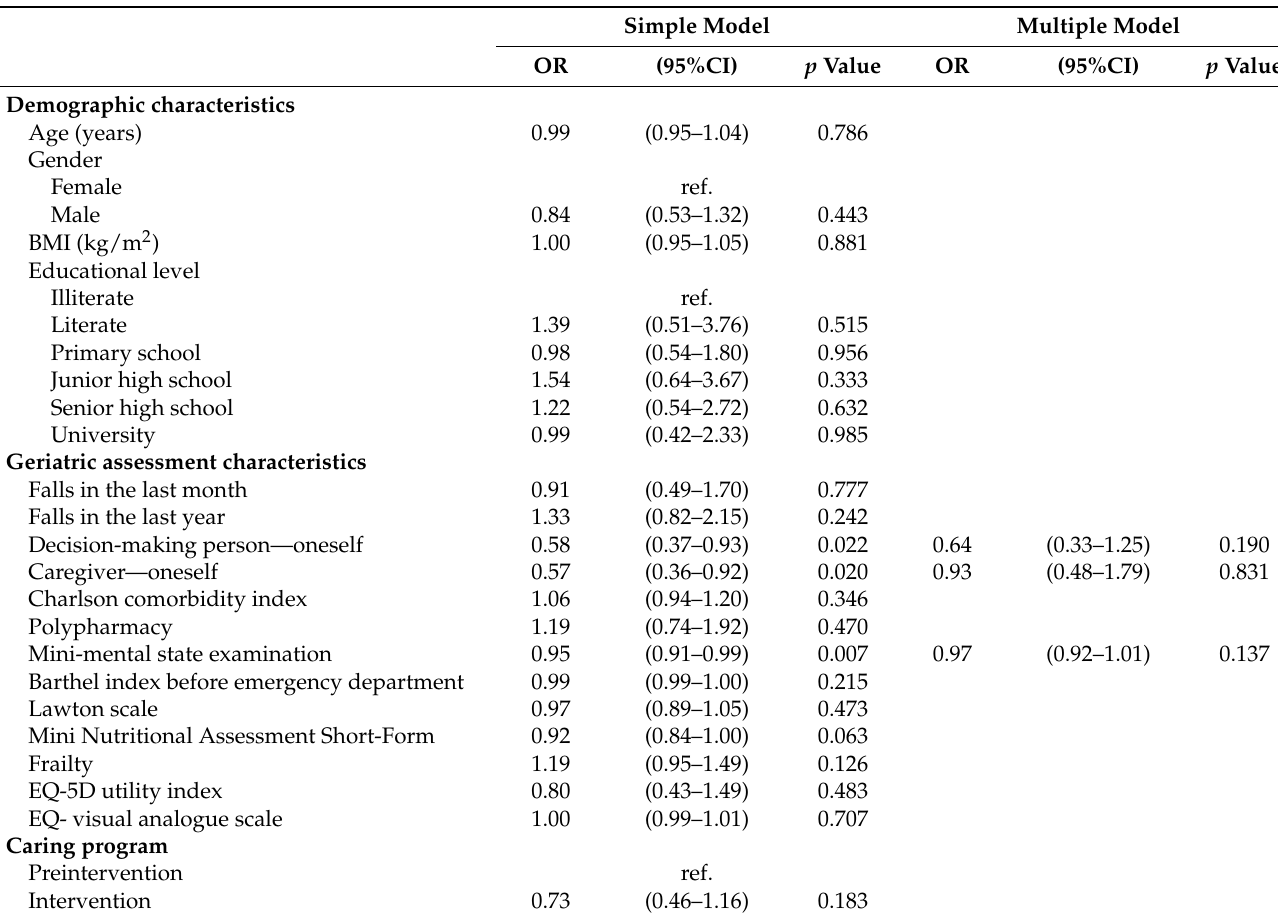
Table 4. Predictors of emergency department revisit within three months.